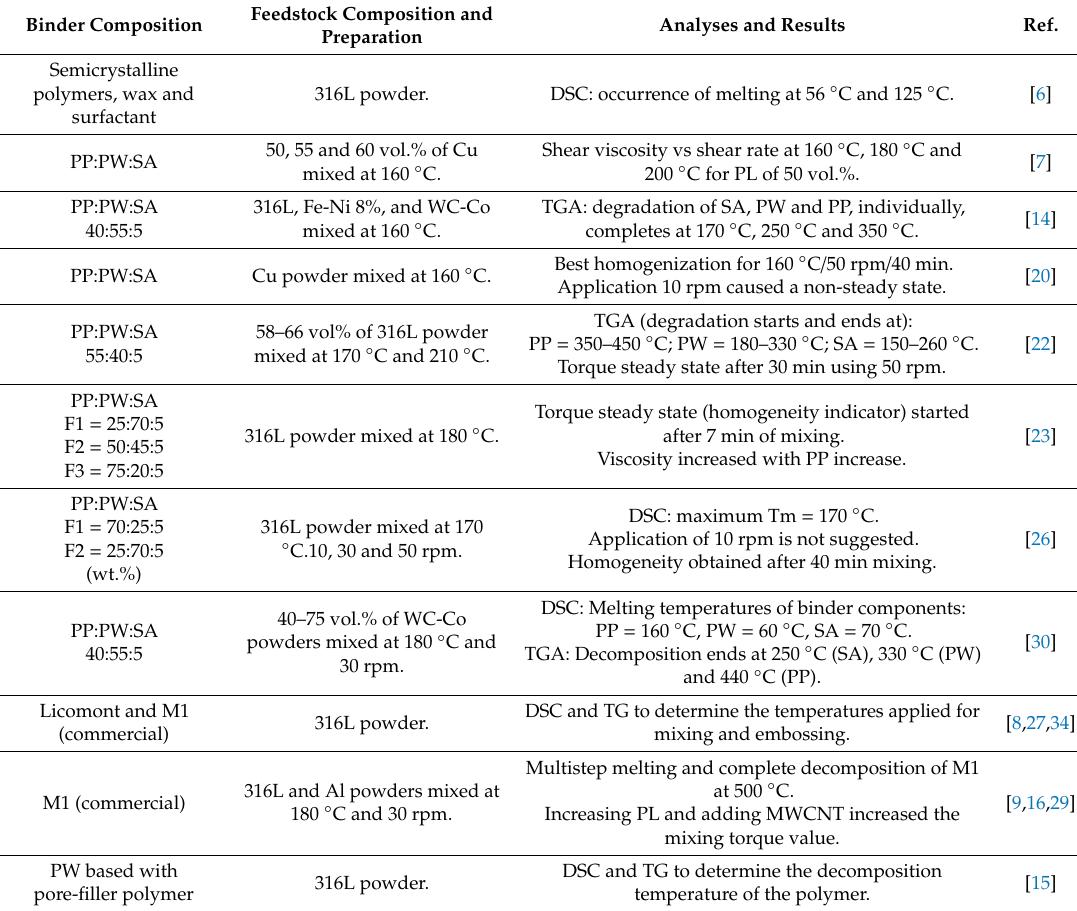
Table 2. Binders, production techniques using a torque mixing method, tests and characteristics of feedstocks used in powder hot